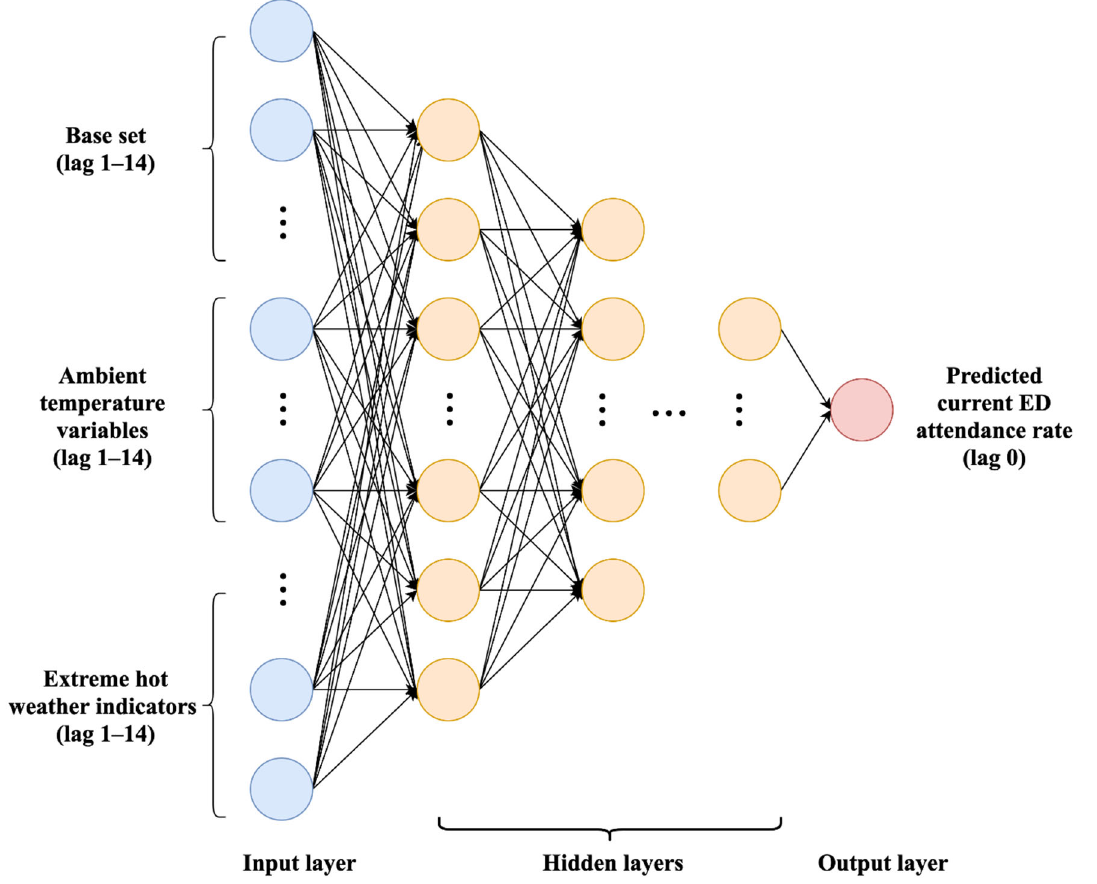
Figure 2. Proposed DNN structure.